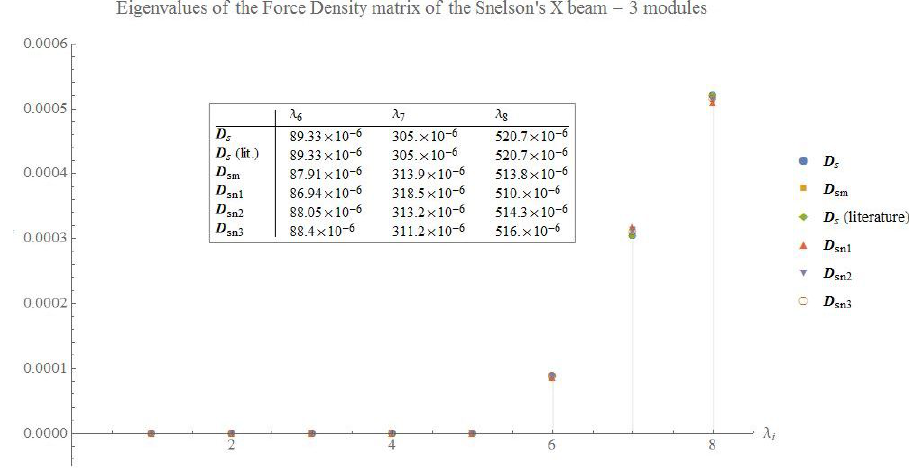
Figure 8: Eigenvalues of the Force Density matrices of the tensegrity Snelson’s X beam with three modules